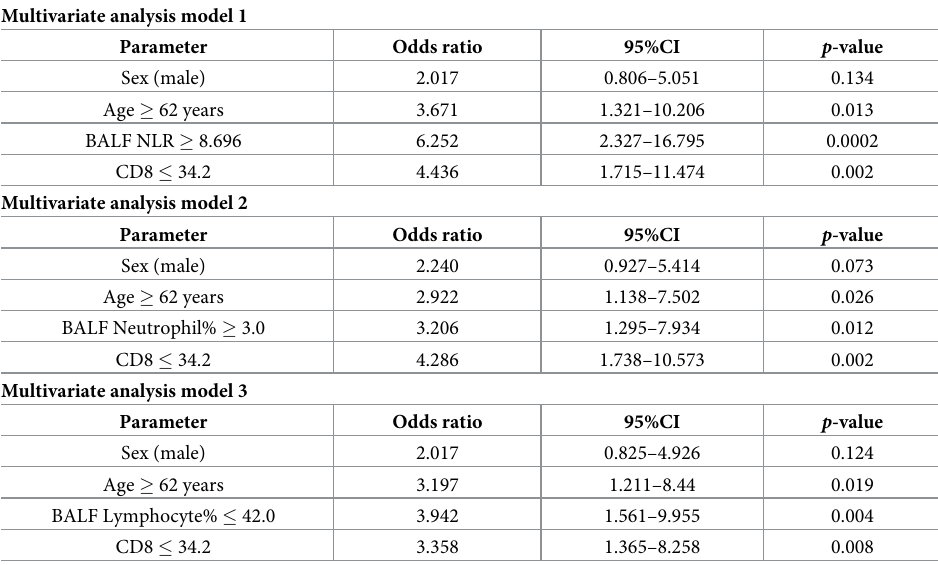
Table 3. Predictive markers of PF-ILD based on multivariate logistic regression analysis.